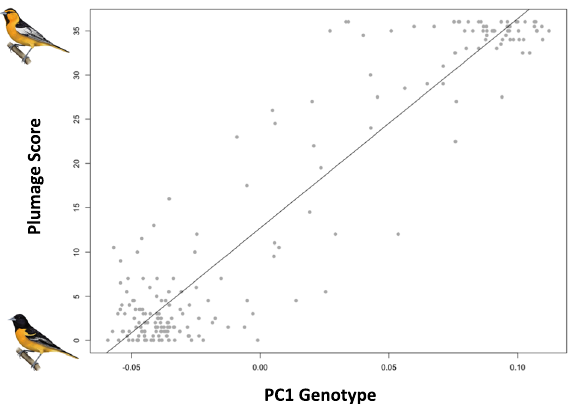
Fig. 3 Correlation between genotype and phenotype in Baltimore and Bullock ’ s orioles. PC1 for genotype (x axis) represents the fi rst axis of a PCA based on amplitypes from candidate melanogenesis genes for all transect individuals. Corresponding plumage scores are on the y